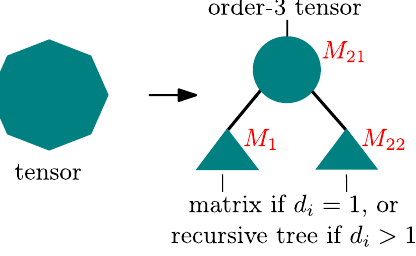
Figure 5. Schematic of the recursion in Algorithm 7 for M 1 and M 2 . The root of the tree (the core) is either a matrix, at the top of the recursion hierarchy, or an order-3 tensor that connects to its parent node and its two